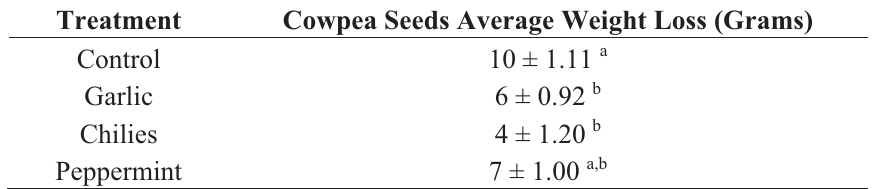
Table 3. Average weight loss of cowpea seeds treated with natural plant products and exposed to attack by the cowpea weevil, C. maculatus